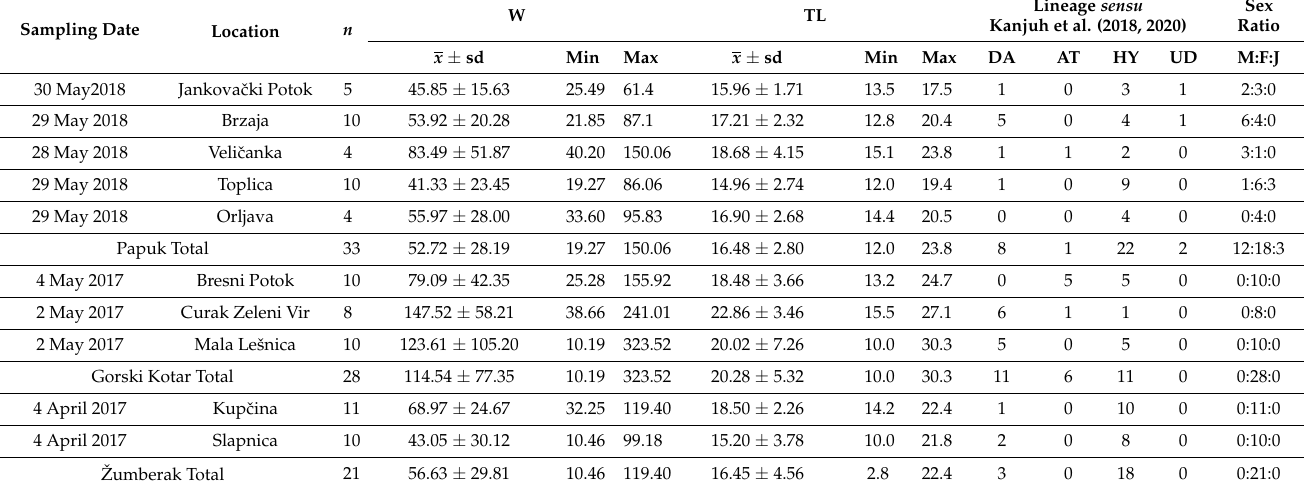
Table 1. Descriptive statistics of sampled brown trout specimens from 10 streams with affiliation to lineages determined by molecular methods ( sensu Kanjuh et al. [5]), ( n = number of specimens; 𝑥̅ = average; W = weight (g); TL = total length (cm); DA = Danube lineage; AT = Atlantic lineage; UD — undeterminable; HY = hybrids; M = male; F = female; J = juveniles).